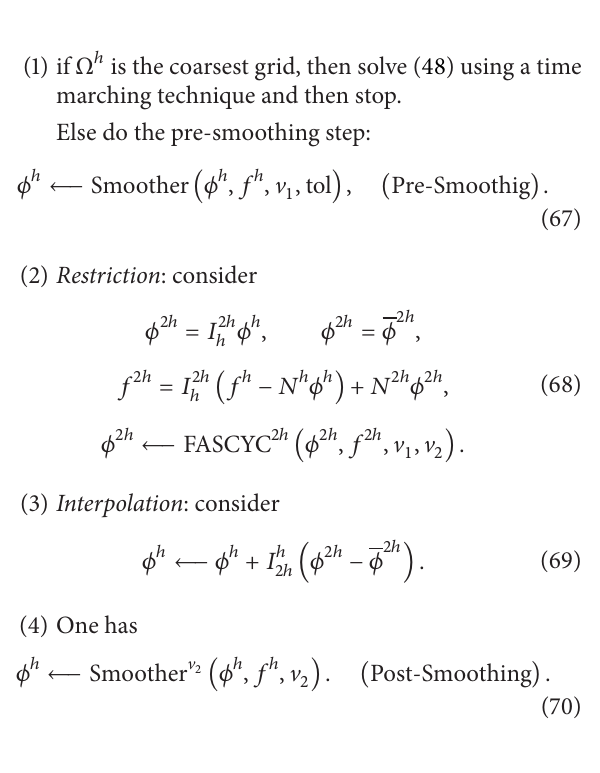
right-hand side vector. On each level 𝑈 0 needs only one fac- torization. The factorization cost of 𝑈 0 is negligible because matrix B has constant blocks which does not change from one grid line to another grid line. In Multigrid method with LU-decompositon or Gauss- Seidel relaxations, we use bilinear interpolation to transfer correction from a coarse grid to a fine grid, and we also use a full-weighting scheme to update the residual on a coarse grid. Algorithm 1 (Multigrid Algorithm). Assuming that we set up these Multigrid